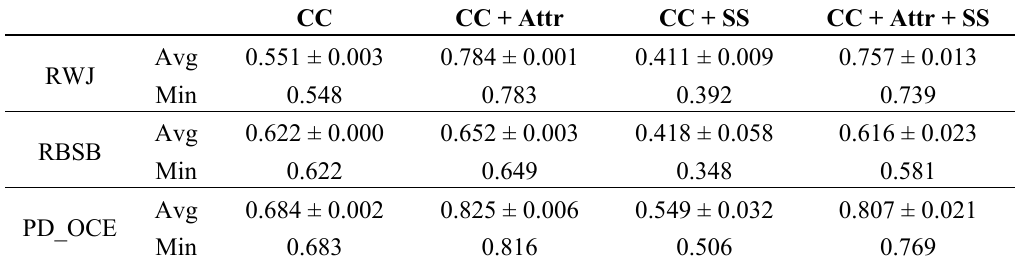
Table 9. Method performance on the Jowhaar problem. The method variant employing a data mapping function (CC + SS) performed the best under all metric